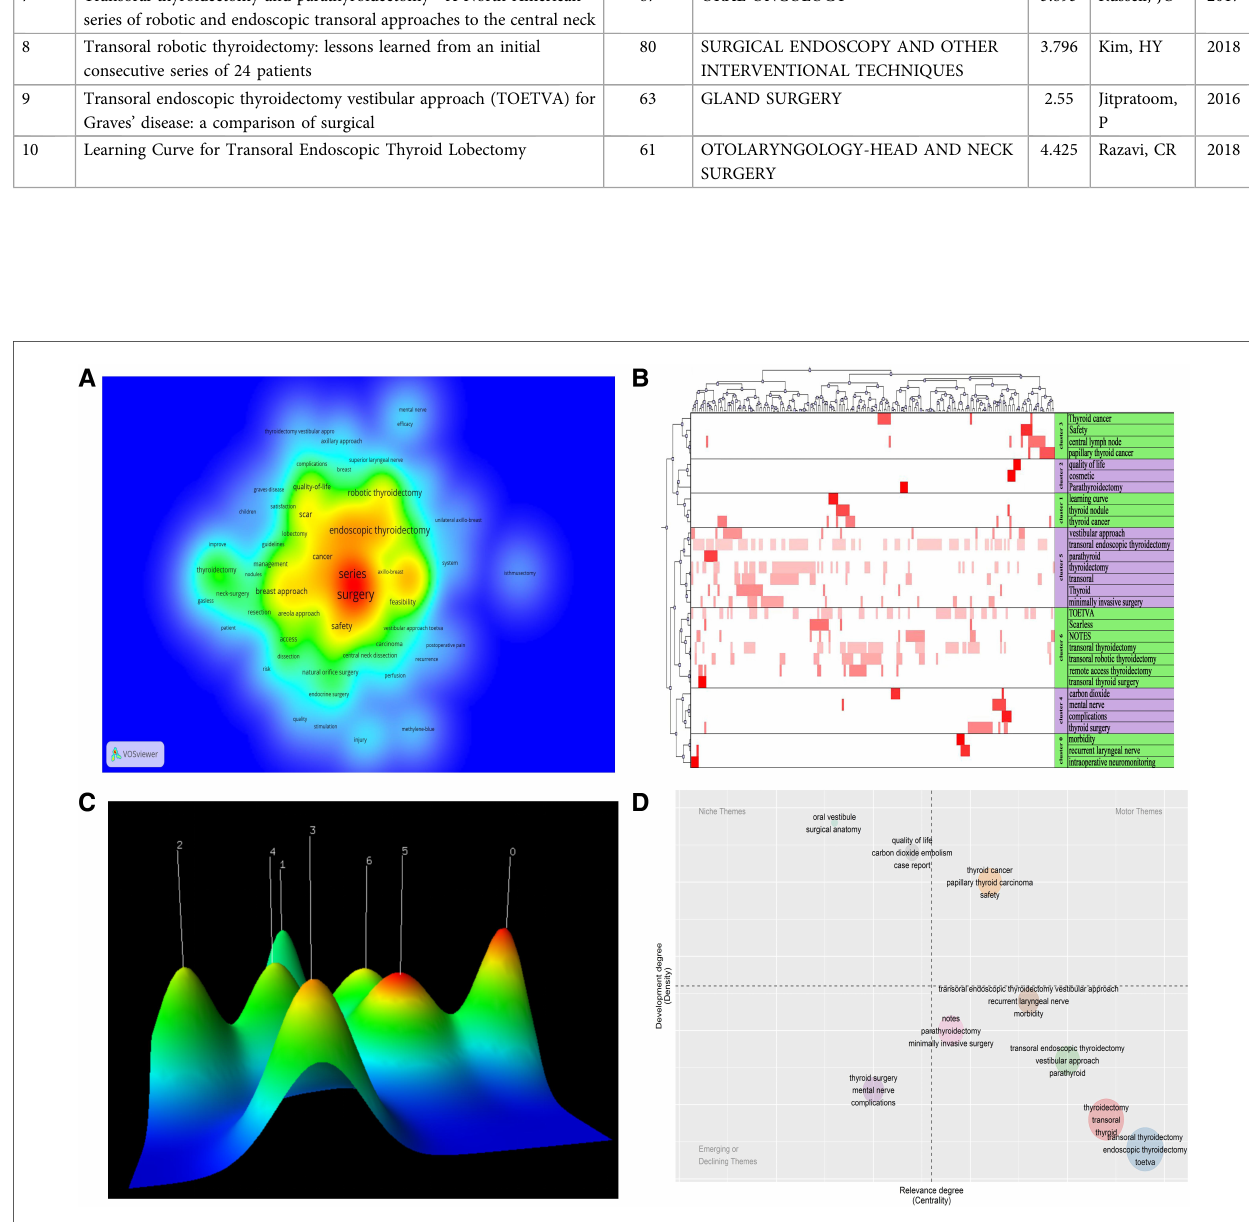
FIGURE 4 ( A ) the density map of keywords; ( B ) the visualized heat map linked to data matrix of keywords; ( C ) the visualized mountain map of theme clustering; ( D ) the thematic map of keywords (bubble